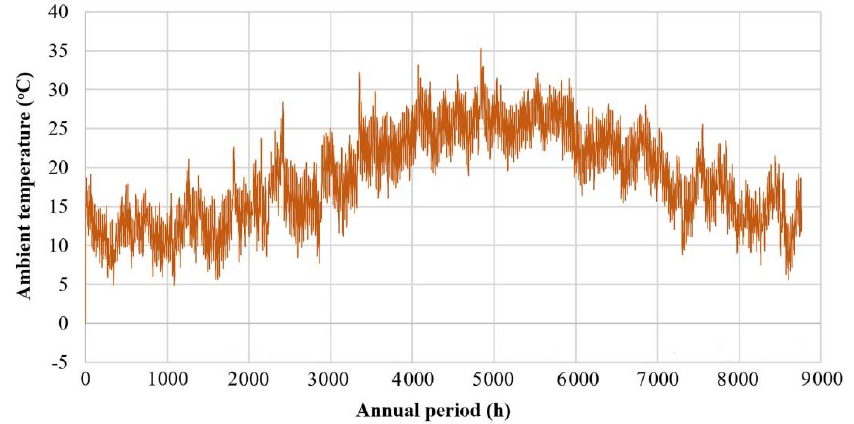
Figure 5. The annual ambient temperature time series at the town of Arkalochori.